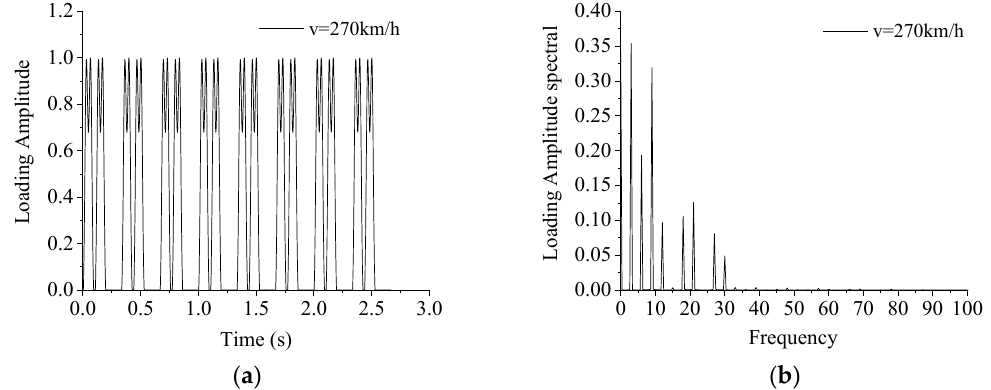
Figure 16. Dynamic loading wave (v = 270 km/). ( a ) waveform of dynamic loading wave, ( b ) frequency distribution of dynamic loading wave.